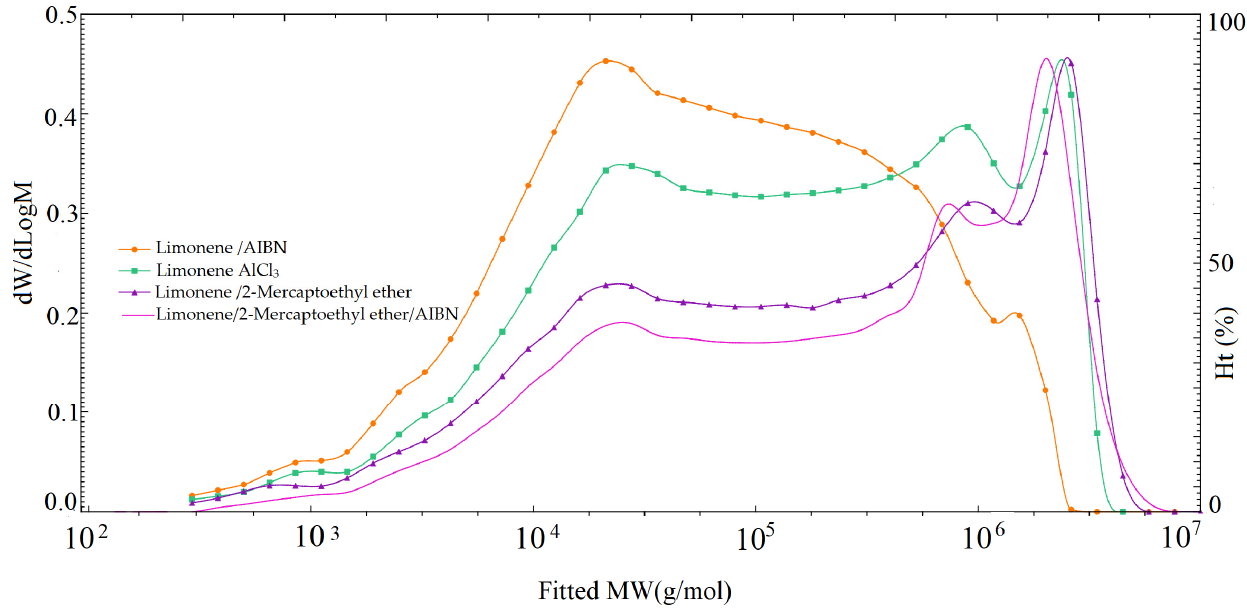
Figure 11. Molecular mass distribution of the synthesized samples.